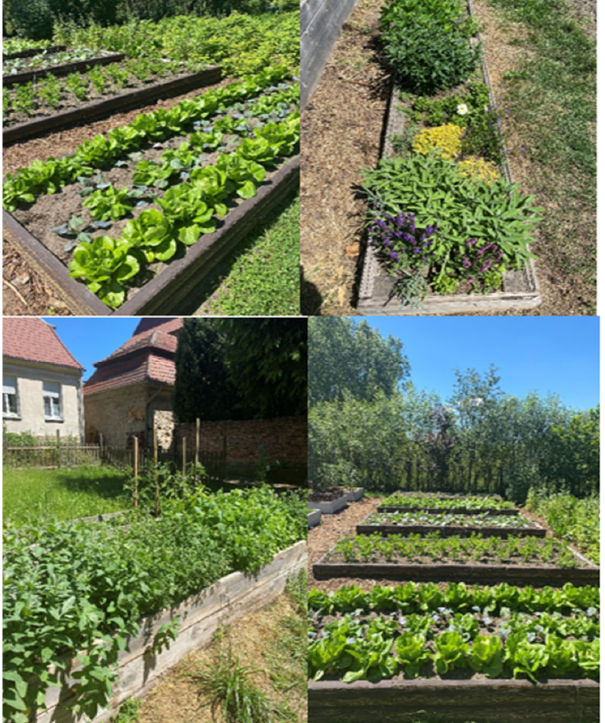
Figure 6. Wooden boxes for cultivation of plants in a community garden (Roman Andrzejak 2022).